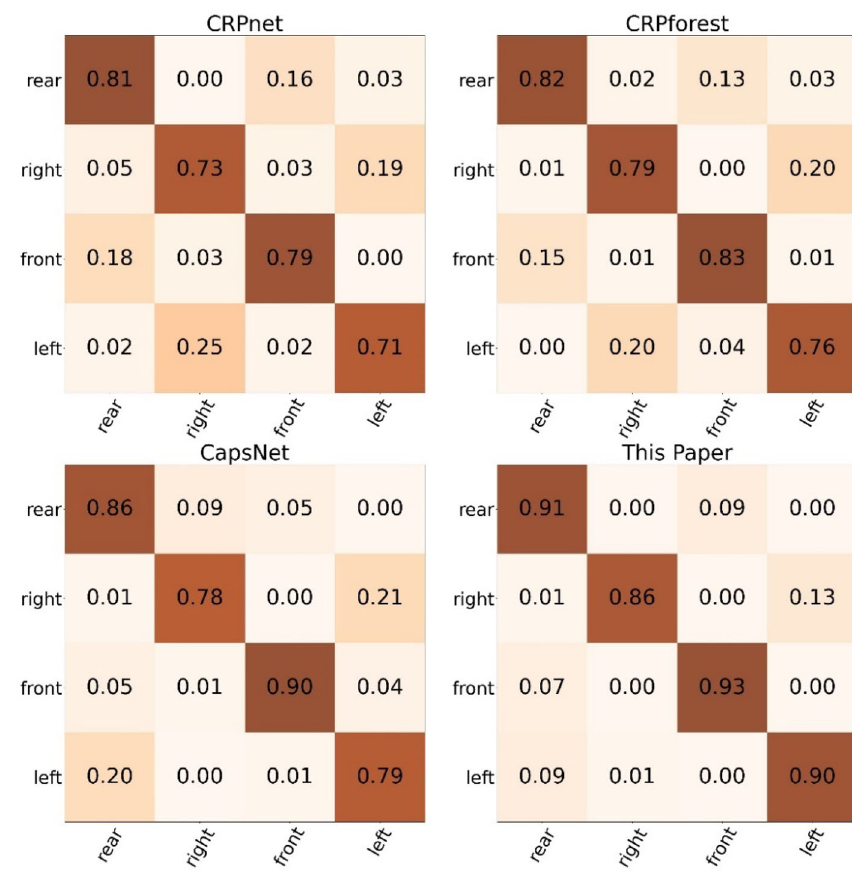
Fig. 19 Confusion matrices of various pedestrian orientation classification algorithms on the Cityscapes data set